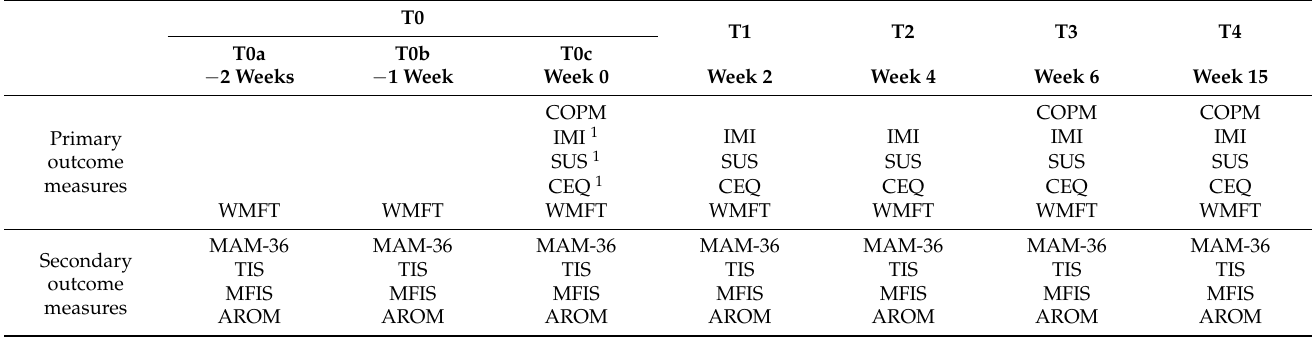
Table 1. Overview of assessments and assessment